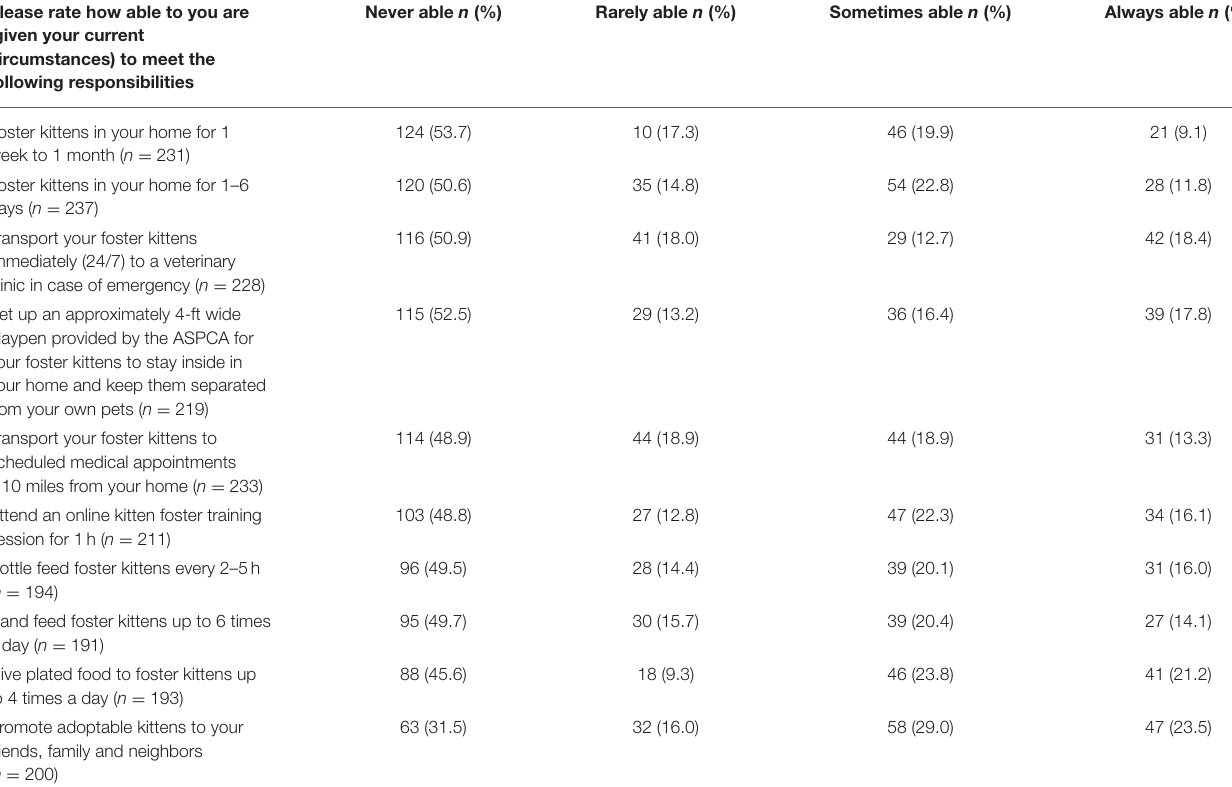
TABLE 4 | Ability to meet common foster program requirements.